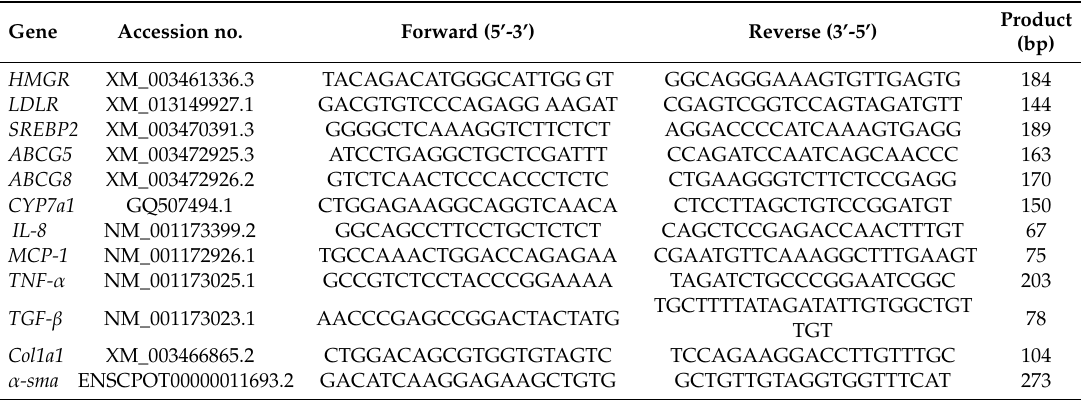
Table 2. qPCR primer